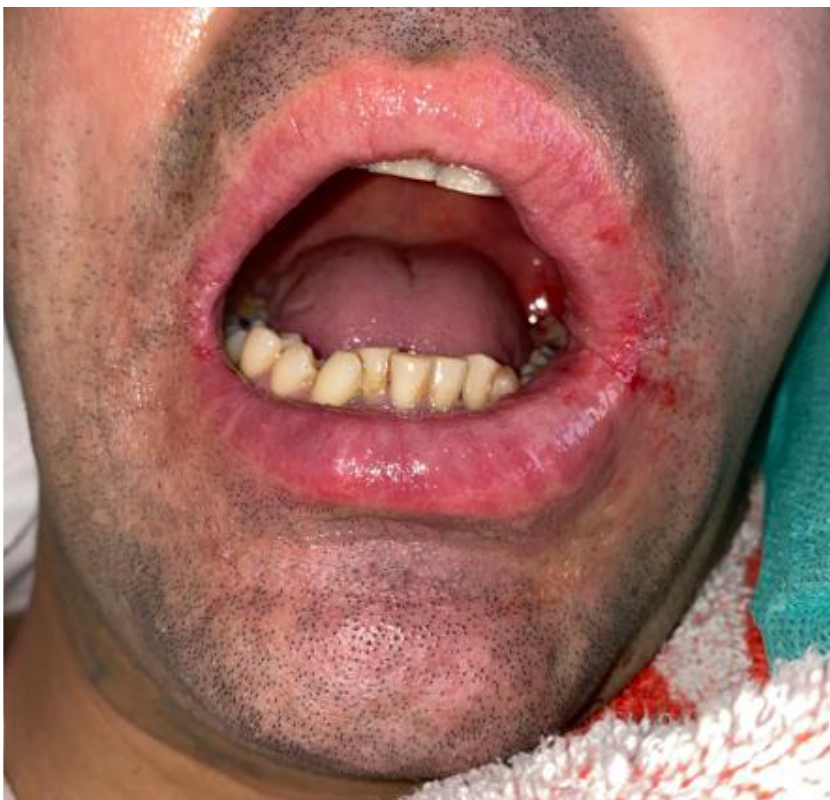
Figure 18. Intraoral approach for coronoidectomy. (Intraoral photographs for visualization pur- poses, from another case). A blue arrow marks the cutting direction for cutting the coronoid process of the mandible.